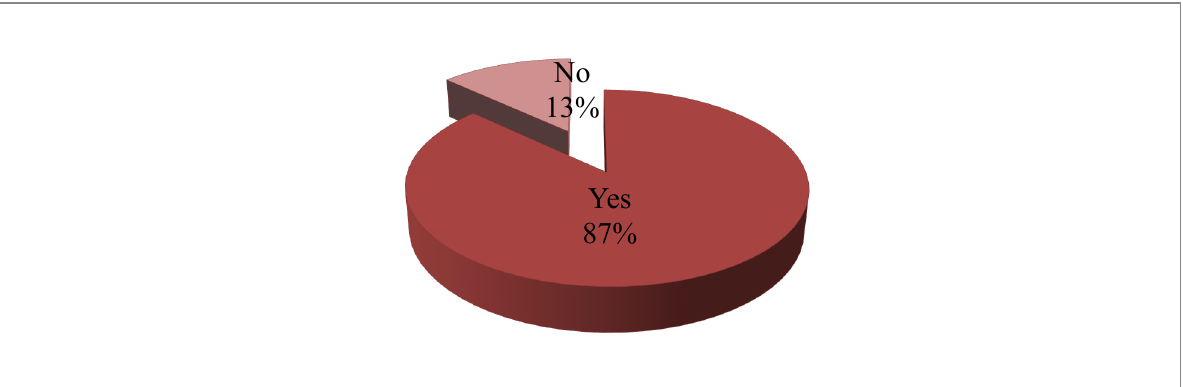
Figure 2: Distribution of respondents depending on external funding.